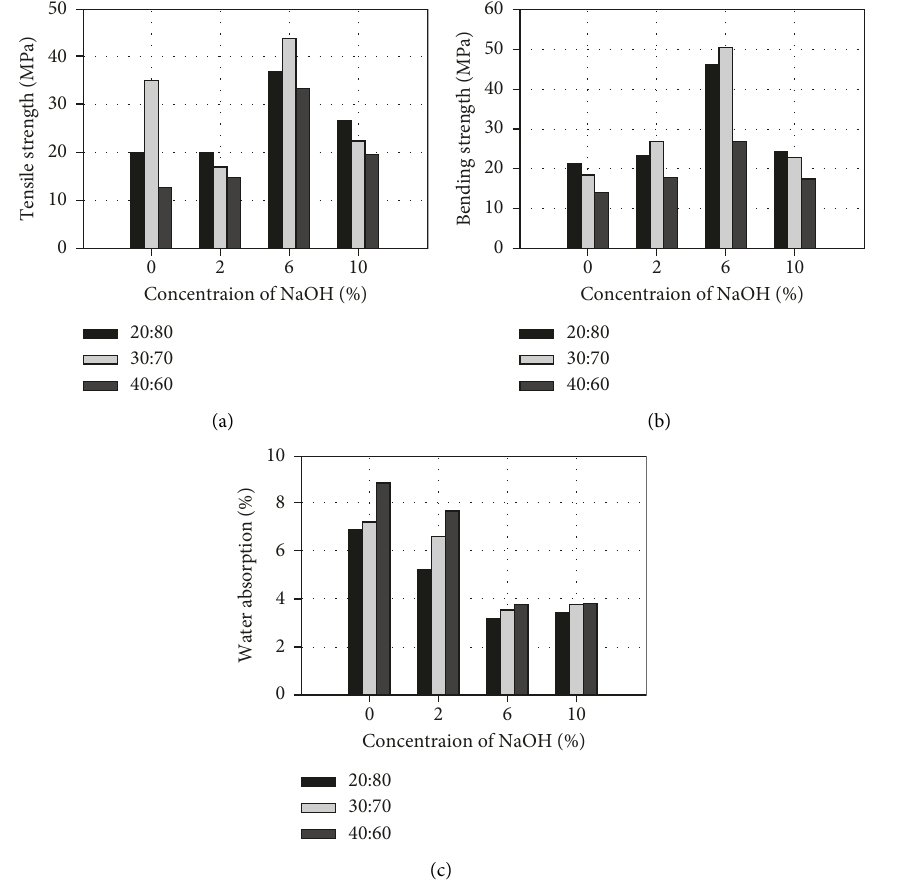
Figure 7: Effect of untreated (raw) fiber to polyester ratio on (a) tensile, (b) bending strength, and (c) water absorption. Table 1: Comparison of flexural strength between various existing single and hybrid fiber composites. Fiber/matrix